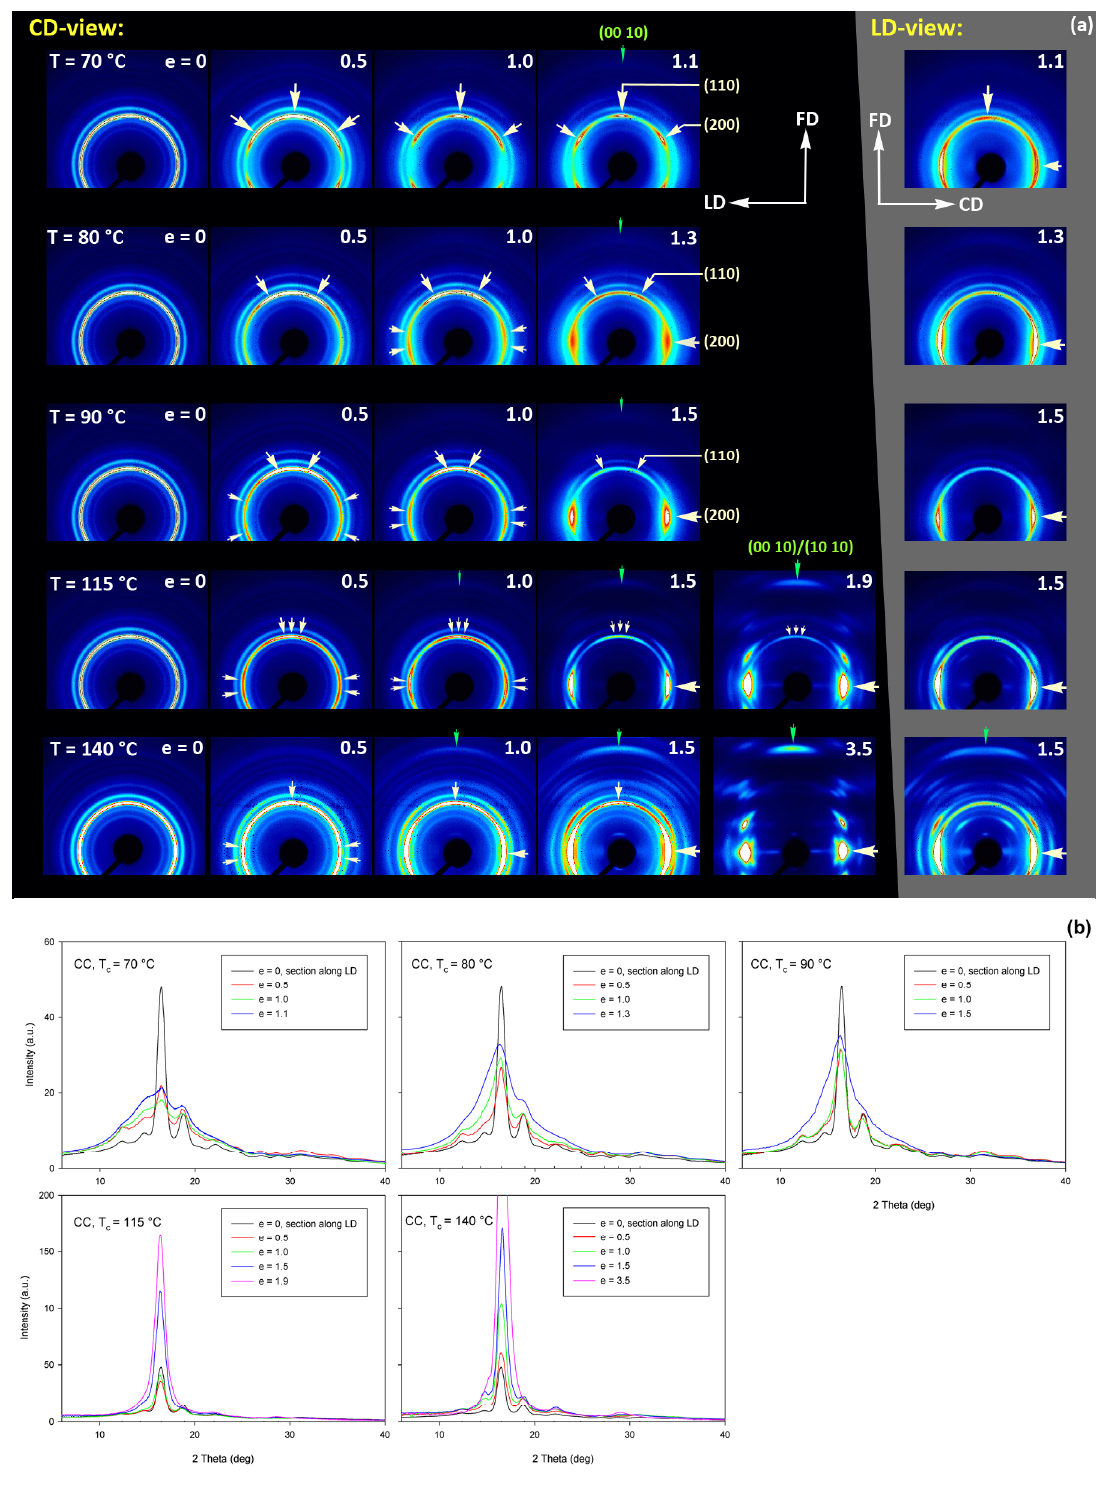
Figure 15. ( a ) Transmission 2D-WAXS patterns of the cold crystallized CC samples deformed in the plane-strain compression at temperature T d = 70–140 °C ( rows from top to bottom ), to the indicated true strain. The patterns on the left (on a black background) were obtained in the CD-view. The column on the right (gray background) shows the patterns collected in the LD-view. The white arrows indicate positions of the maxima in the (200)/(110) reflection, while the green arrows mark the maxima of the (0010)/(1010) reflection. ( b ) One-dimensional radial sections derived from CD-view images along the loading direction, LD, obtained by azimuth integration of 2D patterns in the azimuth range ( − 5°, +5°) around LD ( ψ LD = 0°).